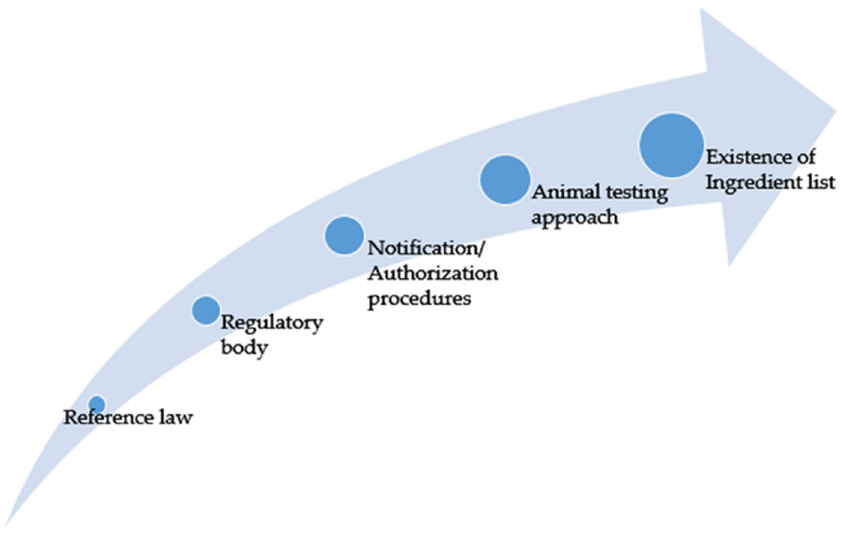
Figure 1. Key points to consider when starting the process of exporting cosmetics